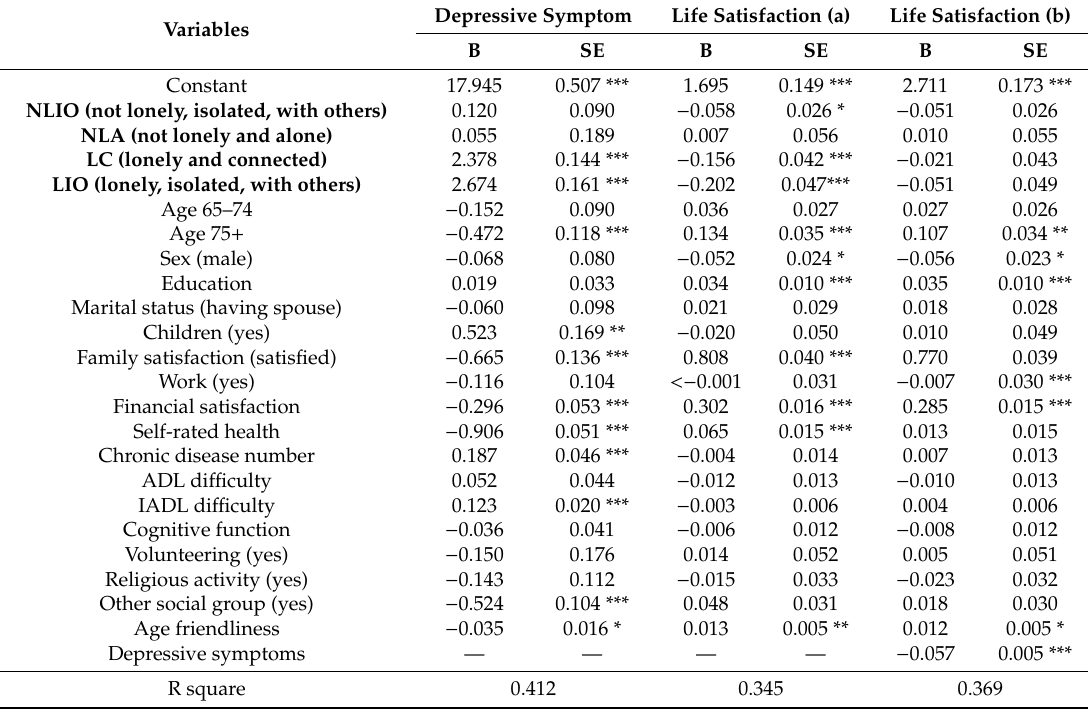
Table 5. LIL and psychological health and well-being by linear